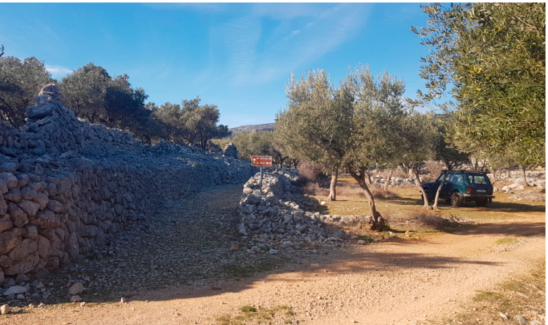
Figure 13. One of the most noticable recent landscape changes in the olive grove are the new roads for vehicles, which sometimes imply perforations of the historical paths. No compensatory measures are currently anticipated (Tanja Kremeni´c, 2019).